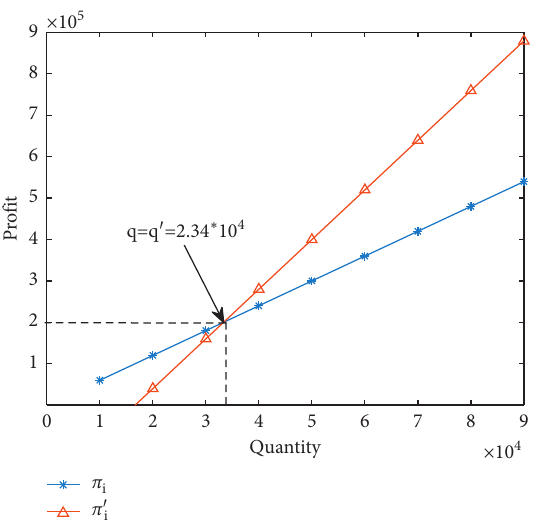
Figure 4: Profits of producers with different scales when n � 6